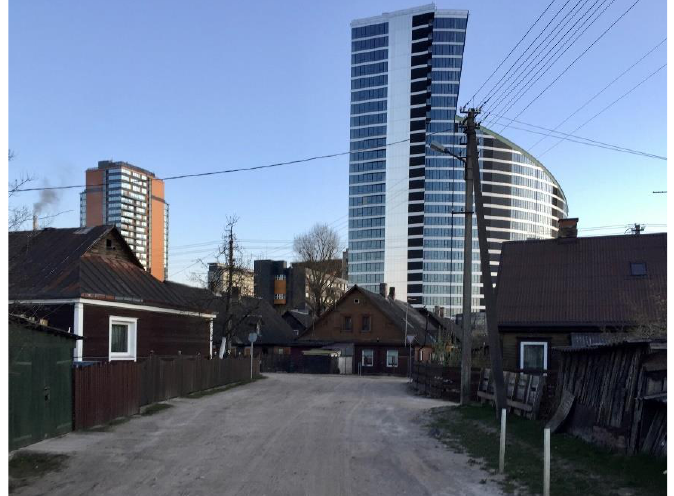
Figure 1. The central part of Šnipiškės. Photo by A. Gabrėnas .